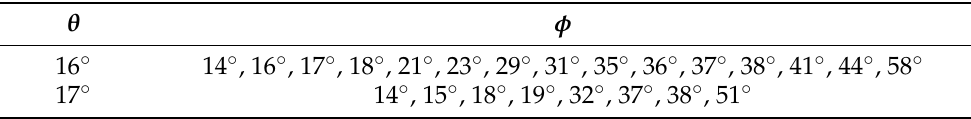
Table 3. Aspect angles used in the